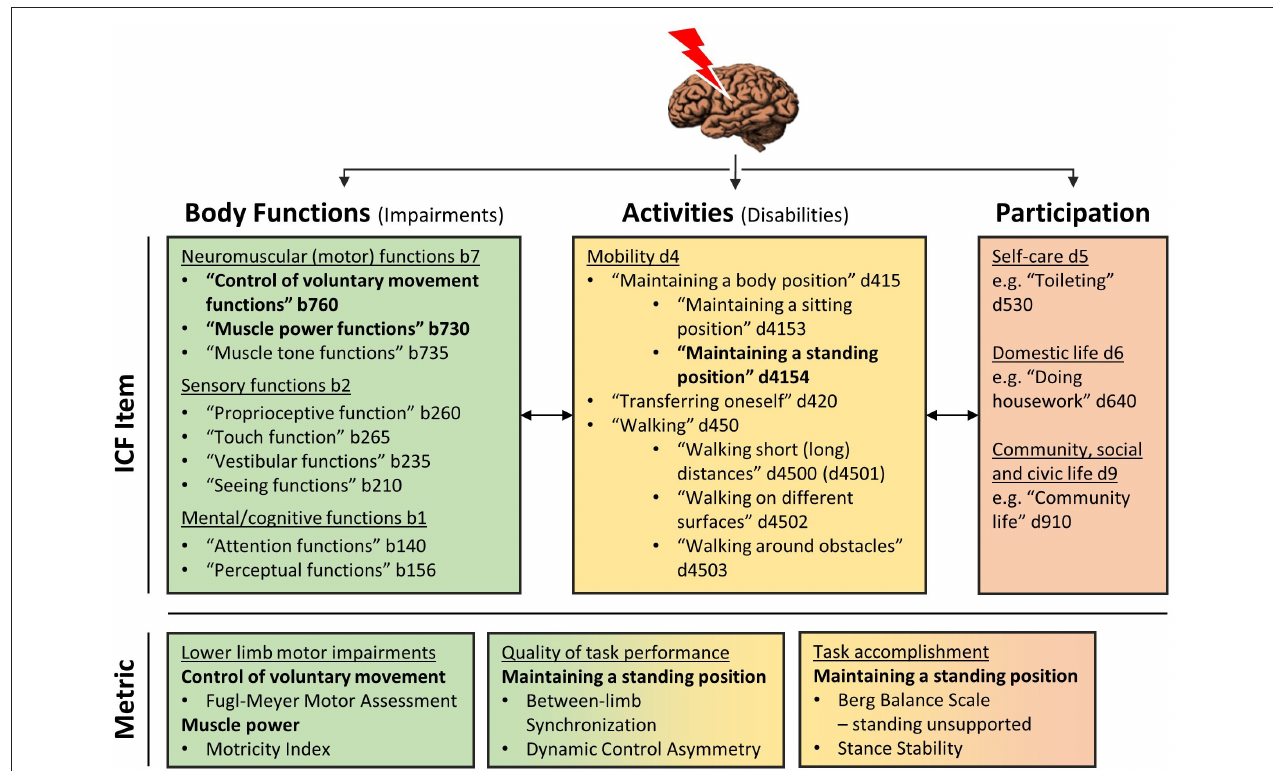
FIGURE 1 | ICF model. The upper panel provides an overview of ICF items that are required for (i.e., level of body functions, colored green) and dependent on (i.e., level of activities, colored yellow, and participation, colored red) standing balance control. The items that are directly assessed in the current study are highlight in bolt. In the lower panel metrics corresponding to these items of interest are provided. The color-coding indicates that metrics of quality of task performance and task accomplishment are both primarily situated on the level of activities, whereas the first indicates how movement execution functions (i.e., level of body functions) are assembled to execute a balance task. Contrary, task accomplishment means if a subjects is successful in maintaining standing balance, irrespective of the underlying control strategy, as a determinant of independence in daily life activities and participation (i.e., level of